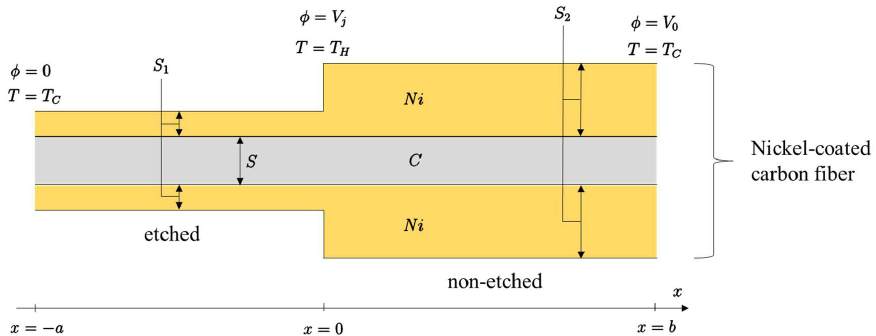
Figure 1. Theoretical diagram of etched and non-etched segment of one filament of nickel-coated carbon fiber as a thermocouple where C is carbon fiber; Ni is nickel coating on the surface of C fiber; S , S 1 , and S 2 are the cross-section areas of C , Ni on etched segment and Ni on non-etched segment, respectively; T is temperature; T C and T H are cold and hot temperatures, respectively; ϕ is electric potential; V j is a voltage at junction ( x = 0); V 0 is a voltage at a single end of nickel-coated carbon fiber ( x = b); x is axis along the thermocouple.